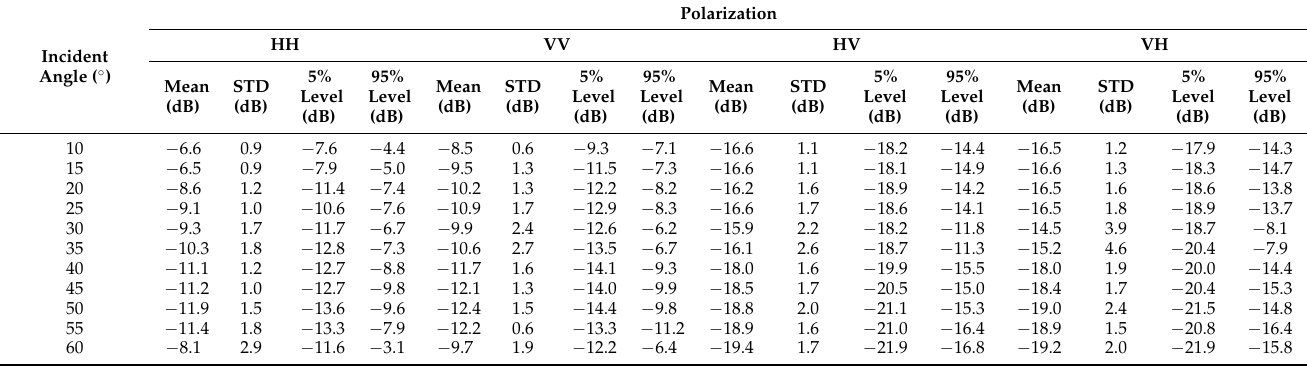
Table 4. Statistical results of the measured backscattering coefficient of rice field scene 1 at the C band.